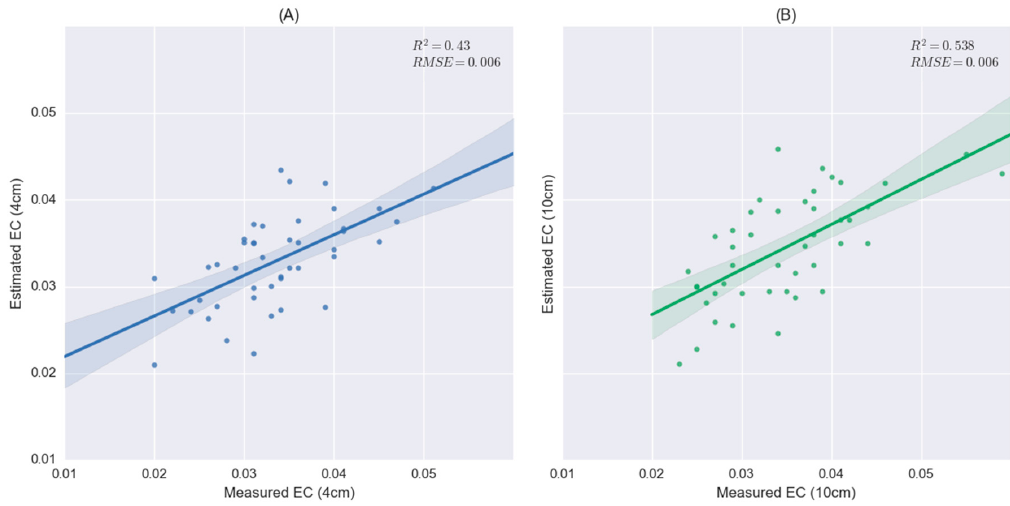
Figure 9. Regression plots between measured target values and estimated values after vegetation suppression for soil salinity at the depth of 4 cm ( A ) and 10 cm ( B ).